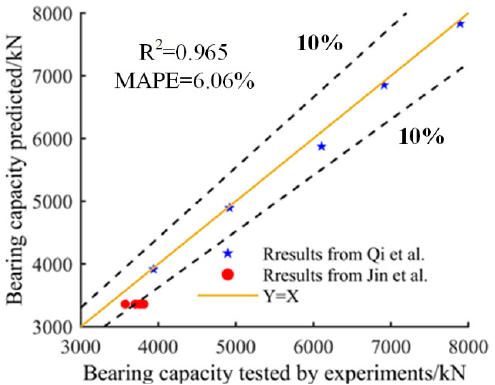
Figure 21. Validation of bearing capacity formula [6,18].